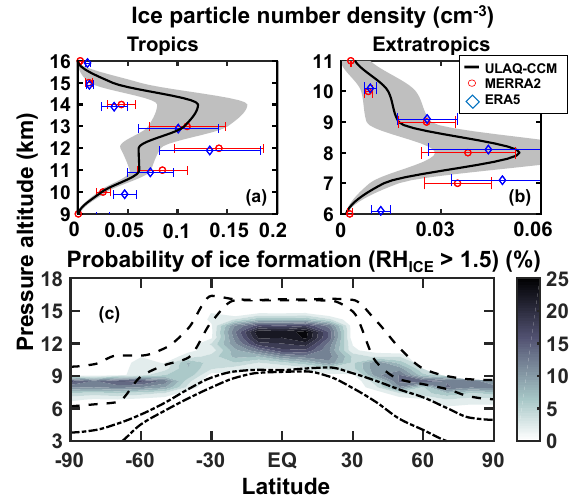
Figure 4. Average upper tropospheric profiles of the ice particle number density (cm − 3 ), for the tropics (25 ◦ S–25 ◦ N; panel a ) and extratropics (35–90 ◦ S, 35–90 ◦ N; panel b ). Time is averaged over the years 2003–2012. The shaded areas represent ± 1 σ for the en- semble over the 10-year period. The red circles show indirectly de- rived values from the MERRA-2 and ERA5 ice mass mixing ra- tio and ULAQ-CCM effective radius (see text). Panel (c) shows the zonally averaged probability of ice formation via homogeneous freezing (percent), as a function of altitude and latitude. The dashed lines show the mean tropopause height (with seasonal variability). The dash-dotted lines show the mean height at which T = 238K (with seasonal